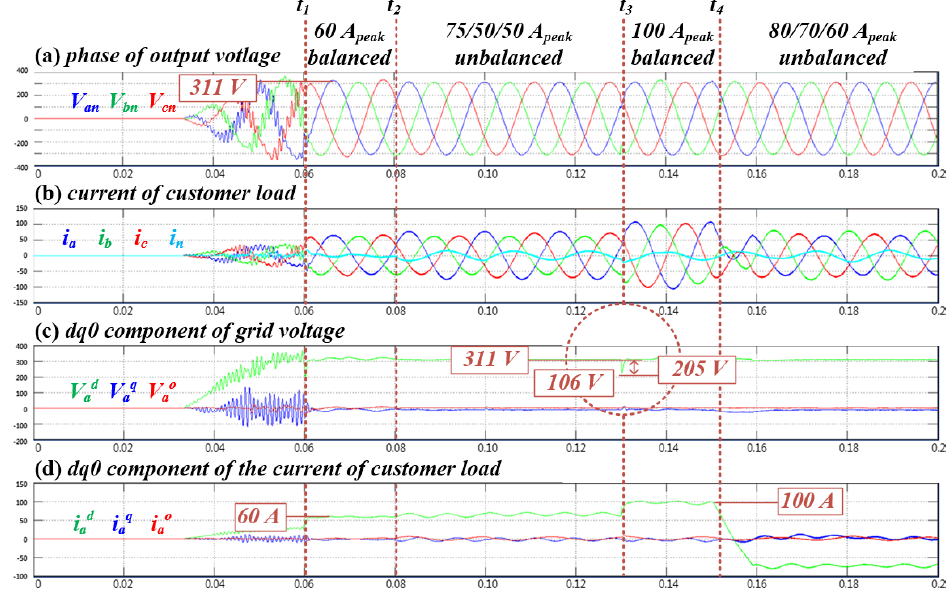
Figure 10. Performance of conventional 3-phase dq0 control.